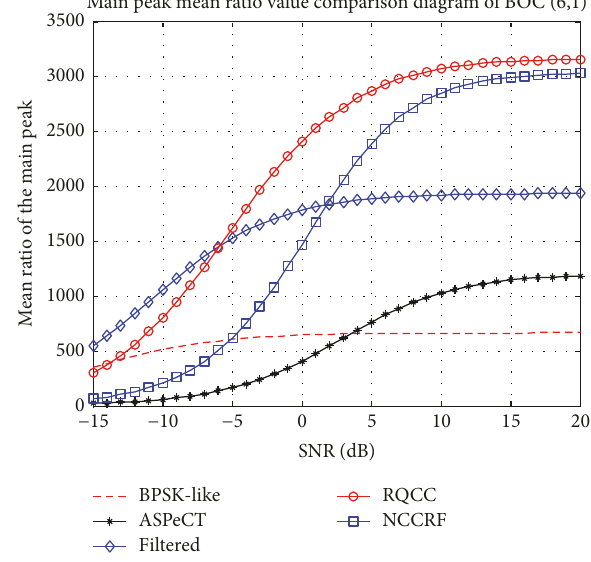
Figure 5: The MPMR comparison of BOC ( 2, 2 ). Main peak mean ratio value comparison diagram of BOC (8,4)